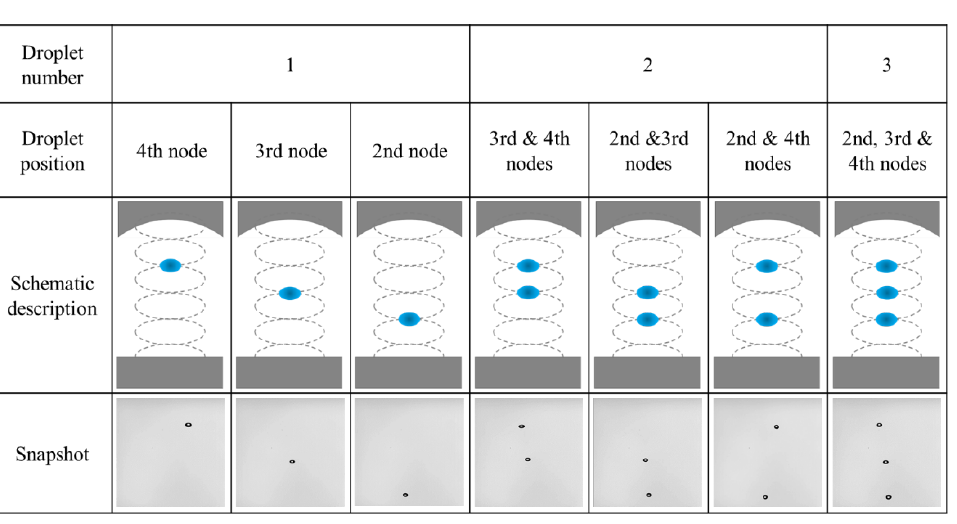
Figure 2. Experimental conditions with single and multiple levitated